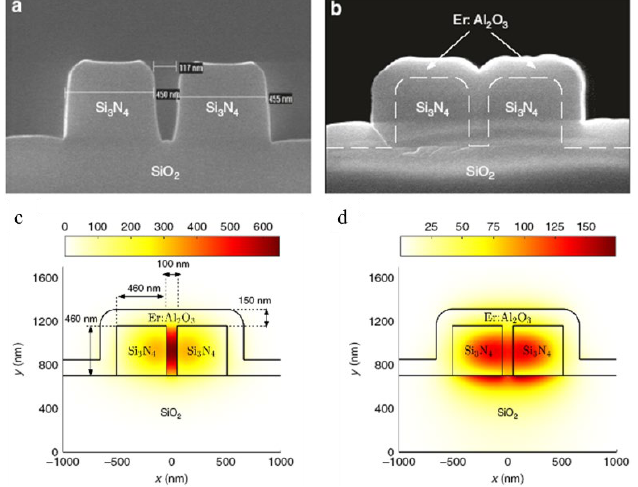
Figure 2. ( a ) The cross-section of the fabricated Si 3 N 4 slot waveguide. ( b ) The cross-section of the Al 2 O 3 :Er–Si 3 N 4 hybrid slot waveguide. ( c ) The TE and ( d ) TM optical mode distribution at 1533 nm in the hybrid slot waveguides [40].